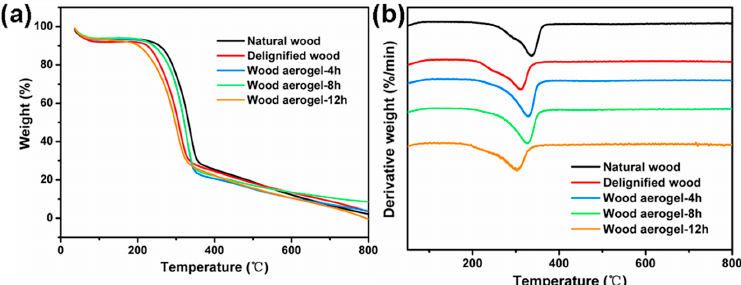
Figure 5. ( a ) Thermogravimetric analysis (TGA) curves and ( b ) Derivative Thermogravimetry (DTG) curves of different wood